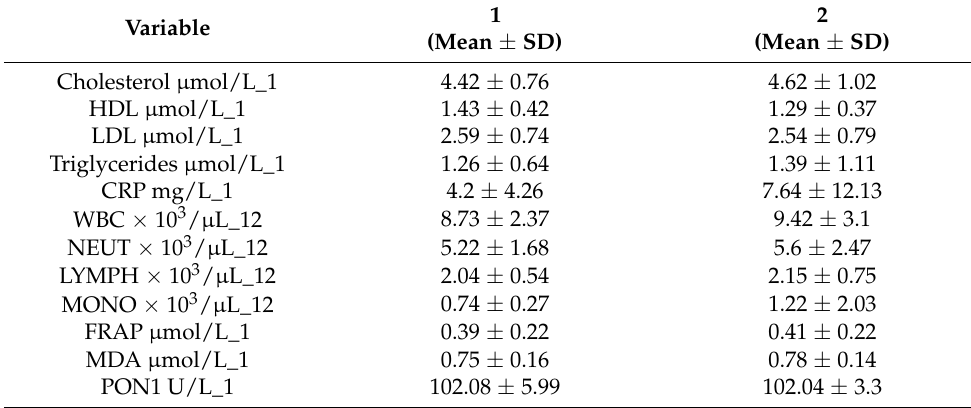
Table 7. Descriptive statistics of the analyzed variables in separate groups of